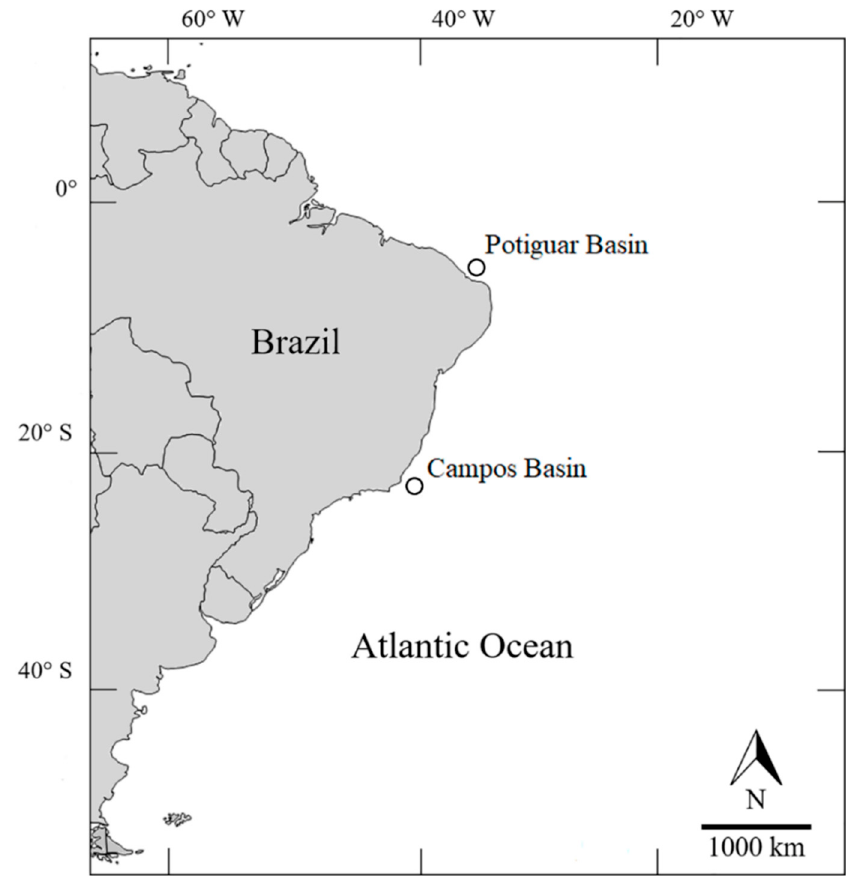
Figure 1. Map of collecting localities (empty circles) in the Potiguar Basin and Campos Basin in the Brazilian continental slope, South-Western Atlantic Ocean.